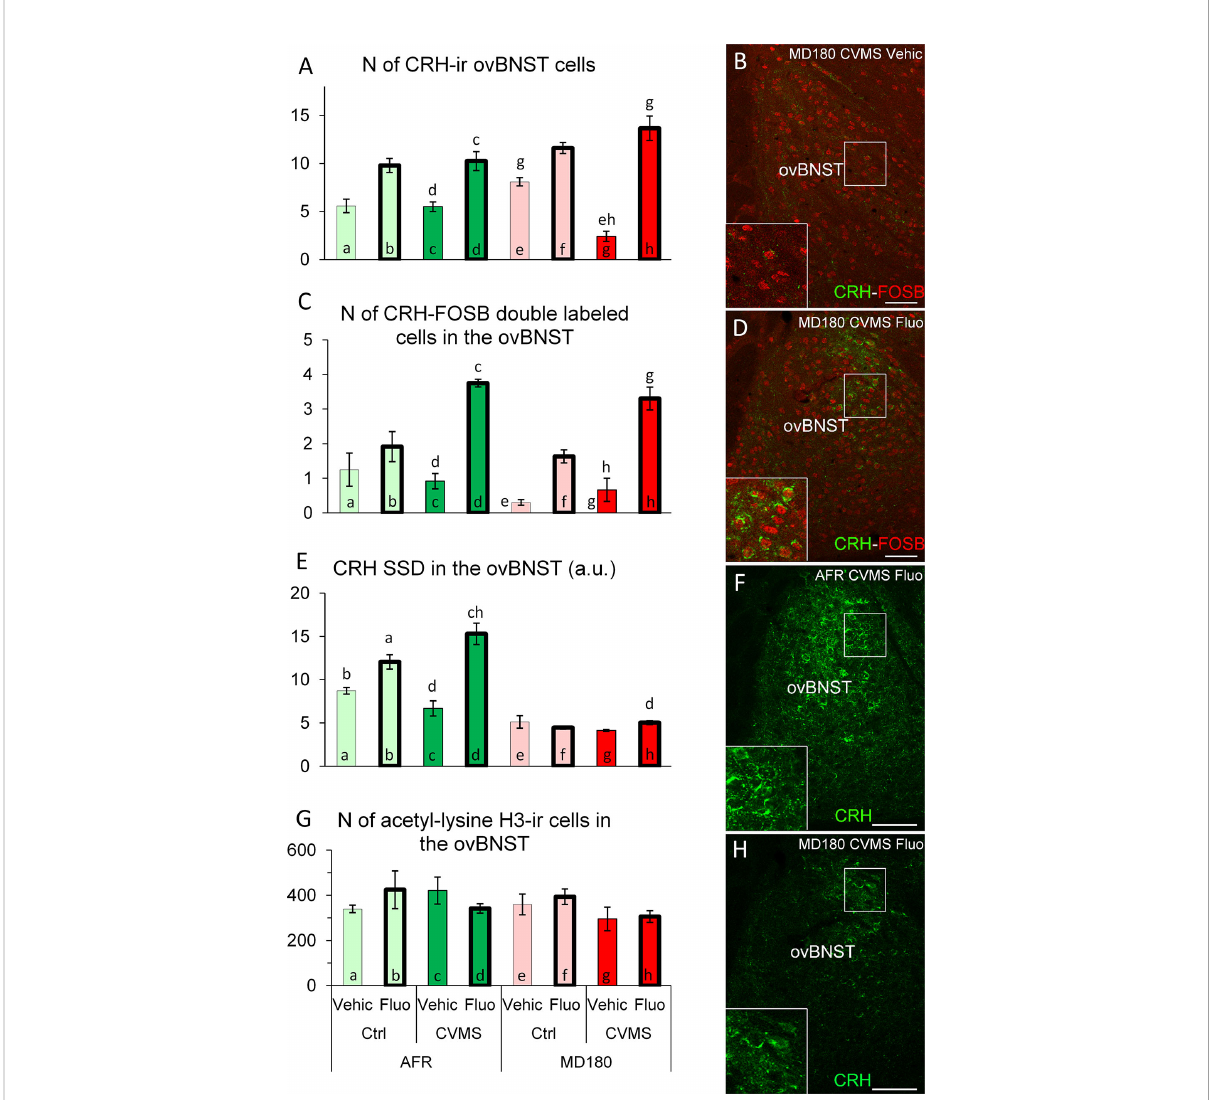
FIGURE 3 Summary of morphological results in the oval division of the bed nucleus of the stria terminalis (ovBNST). (A) Number (N) of corticotropin- releasing hormone (CRH)-immunoreactive (ir) cells in the ovBNST. (C) N of CRH/FOSB double labeled cells in ovBNST. Microphotographs (B) and (D) show CRH (green) and FOSB (red) double labeling immuno fl uorescence in the ovBNST. Representative images of a maternally deprived (MD180), chronic variable mild stress-exposed (CVMS), physiological saline (Vehic)-injected (B) and a MD180, CVMS, fl uoxetine-injected (Fluo) animal (D) . (E) Speci fi c signal density (SSD) of CRH in the ovBNST, expressed in arbitrary units (a. u.). Microphotographs of CRH (green) labeling in the ovBNST illustrate (F) animal facility-reared (AFR), CVMS, Fluo and an MD180, CVMS, Fluo (H) animals. (G) N of acetyl-lysine histone H3-ir cells in the ovBNST. Lettering at the top of bars represents the most relevant signi fi cant statistical differences between pairs of groups according to the post hoc tests (p<0.05). Ctrl: control (i.e. not exposed to CVMS). Bar = 100